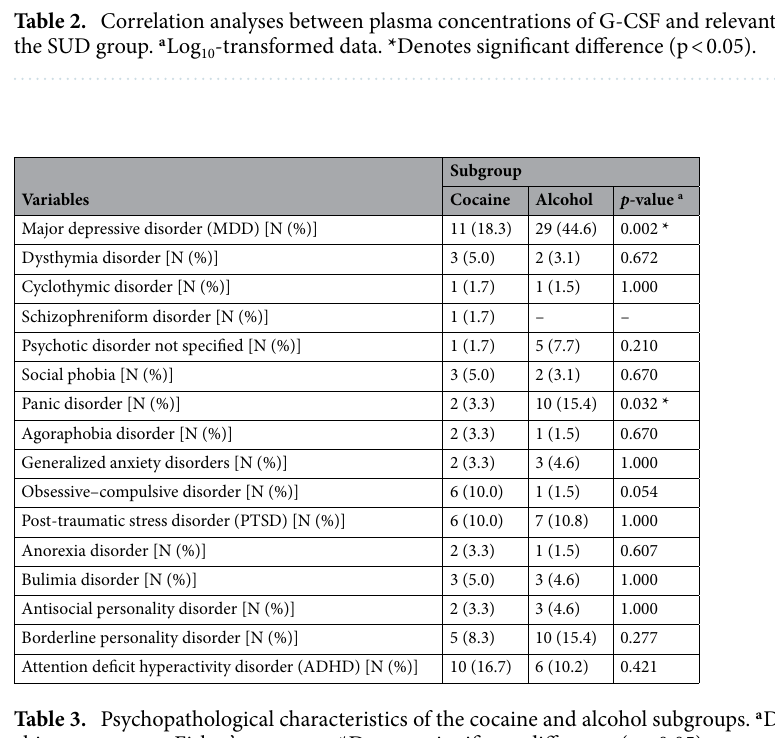
Table 3. Psychopathological characteristics of the cocaine and alcohol subgroups. a Data were analyzed using chi-square test or Fisher’s exact test. * Denotes significant difference (p <